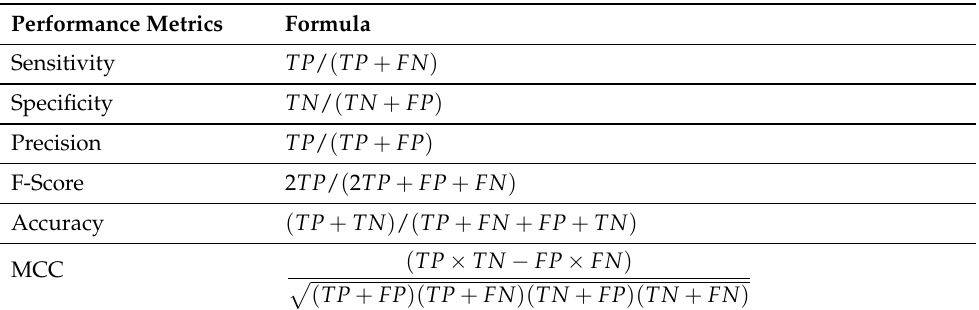
Table 3. The performance metrics for the evaluation of the